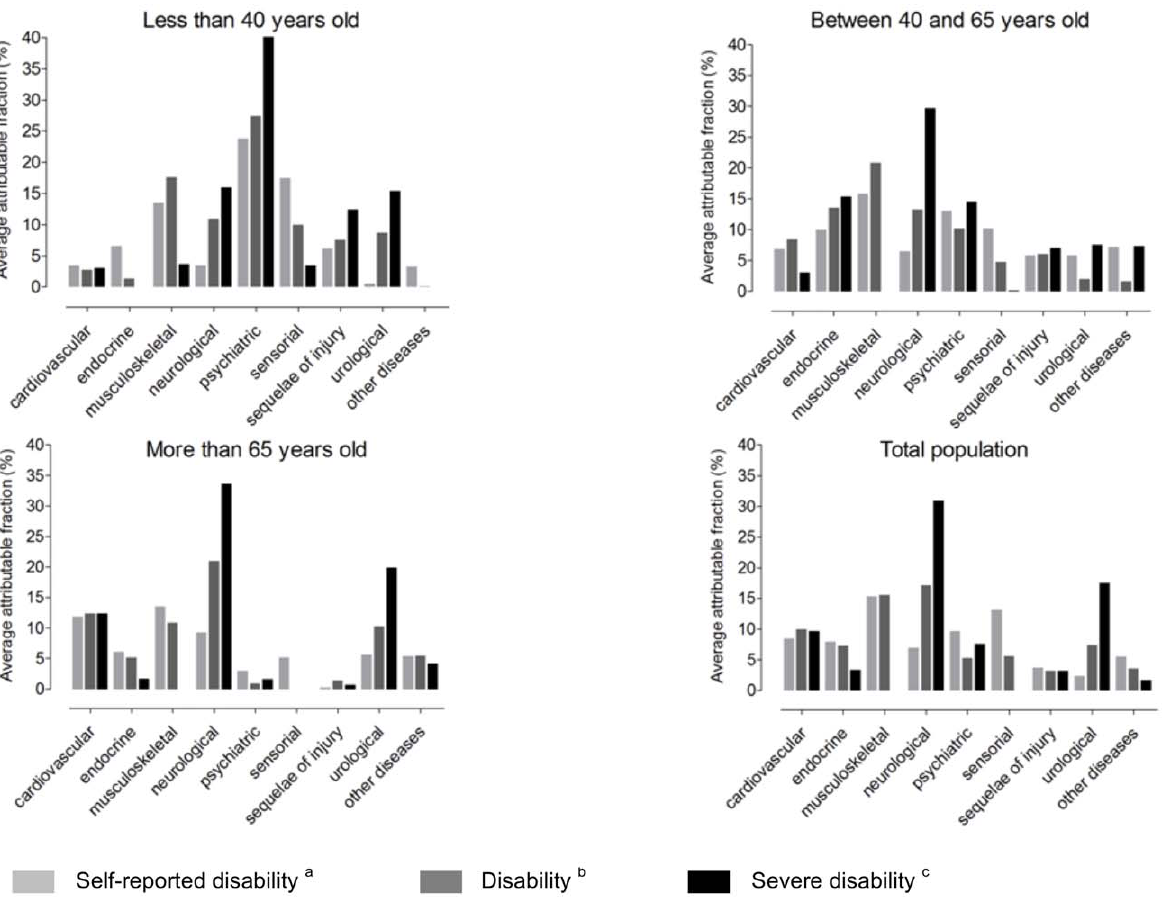
Figure 2. Average attributable fractions of chronic conditions for different categories of disability in France and according to age. a Self-reported disability=positive response to the question ‘‘Do you consider that you have a disability?’’; b Disability=any restriction in doing at least one activity of daily living (ADL) with or without technical aid (self-report assessment); c Severe disability=inability to perform at least one ADL alone (self-report